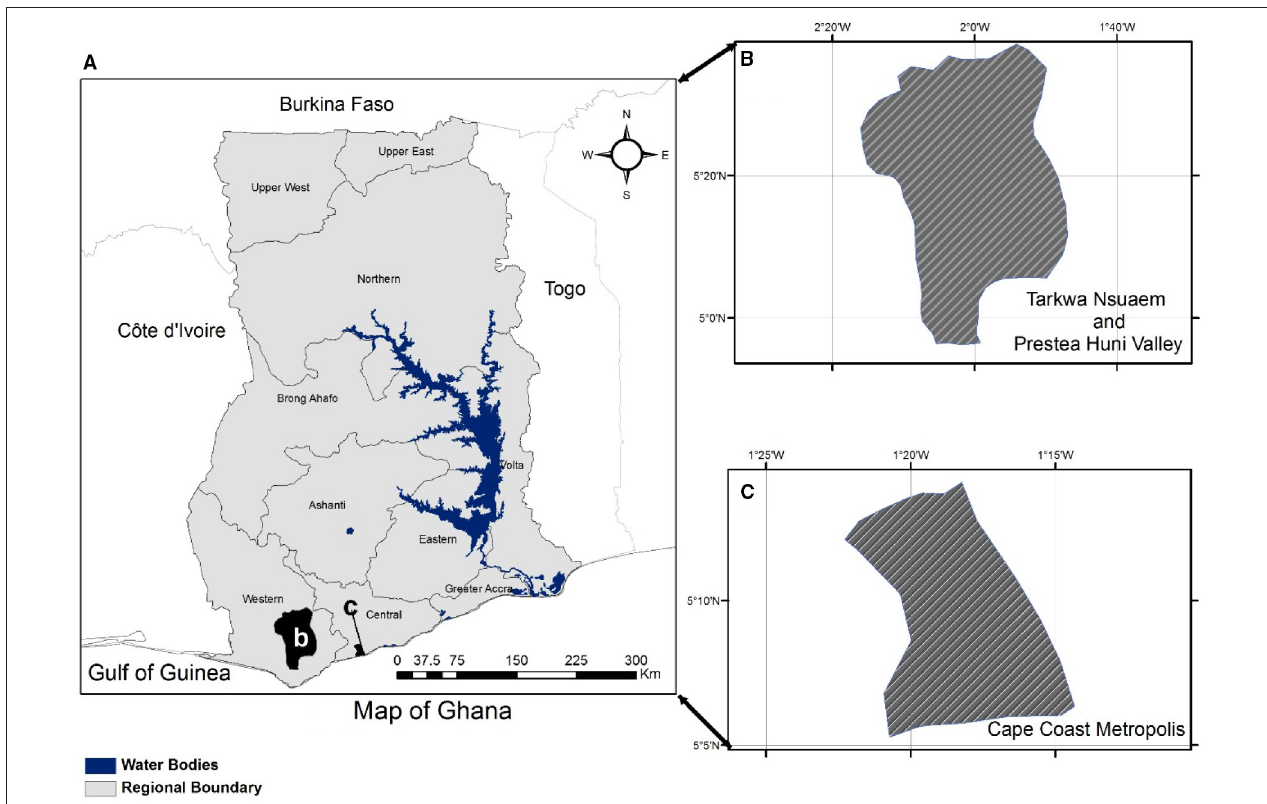
FIGURE 1 | Map of the Tarkwa Nsuaem and Prestea Huni Valley Districts in Southwestern Ghana (source Armah et al., 2012).